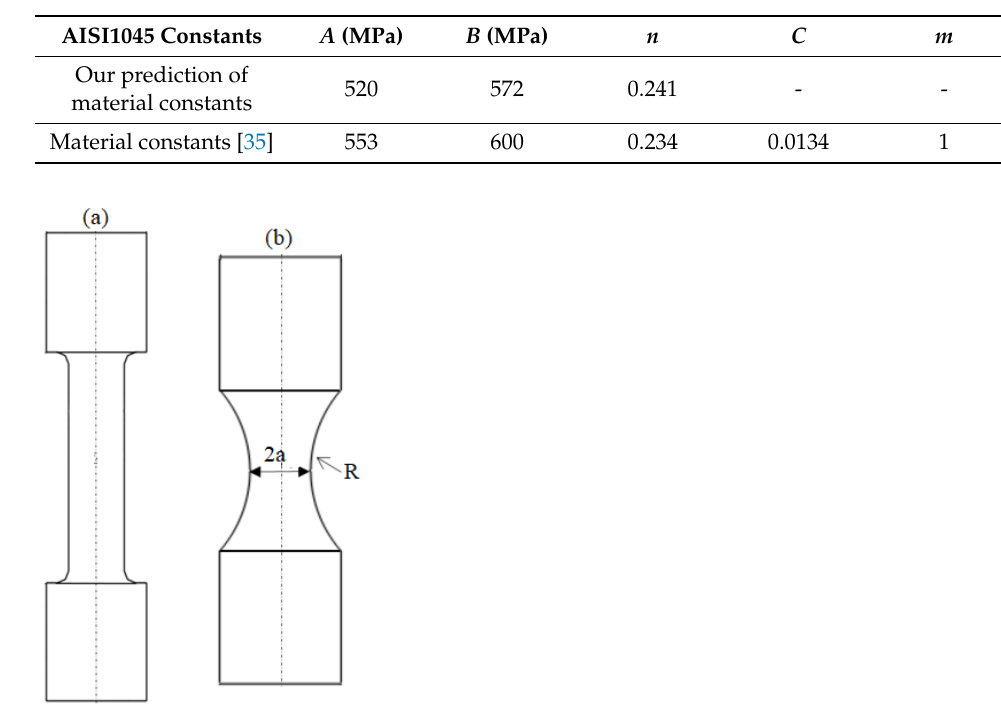
Figure 11. ( a ) Smooth round specimen; ( b ) Notched round specimen.